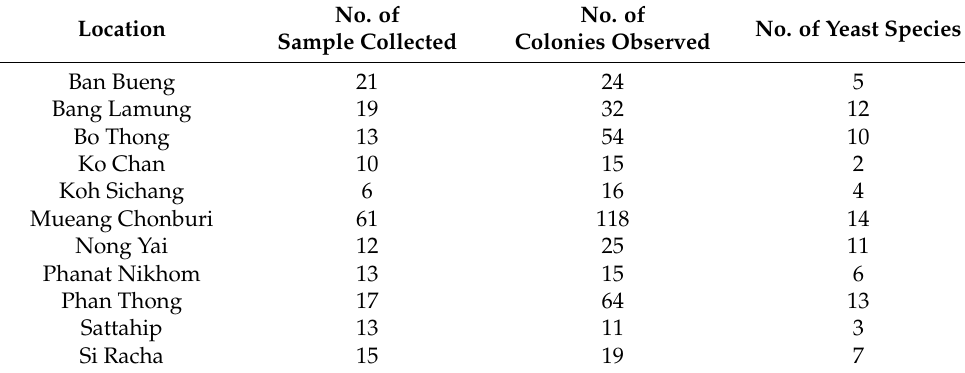
Table 1. Pigeon excreta sample collection. Location